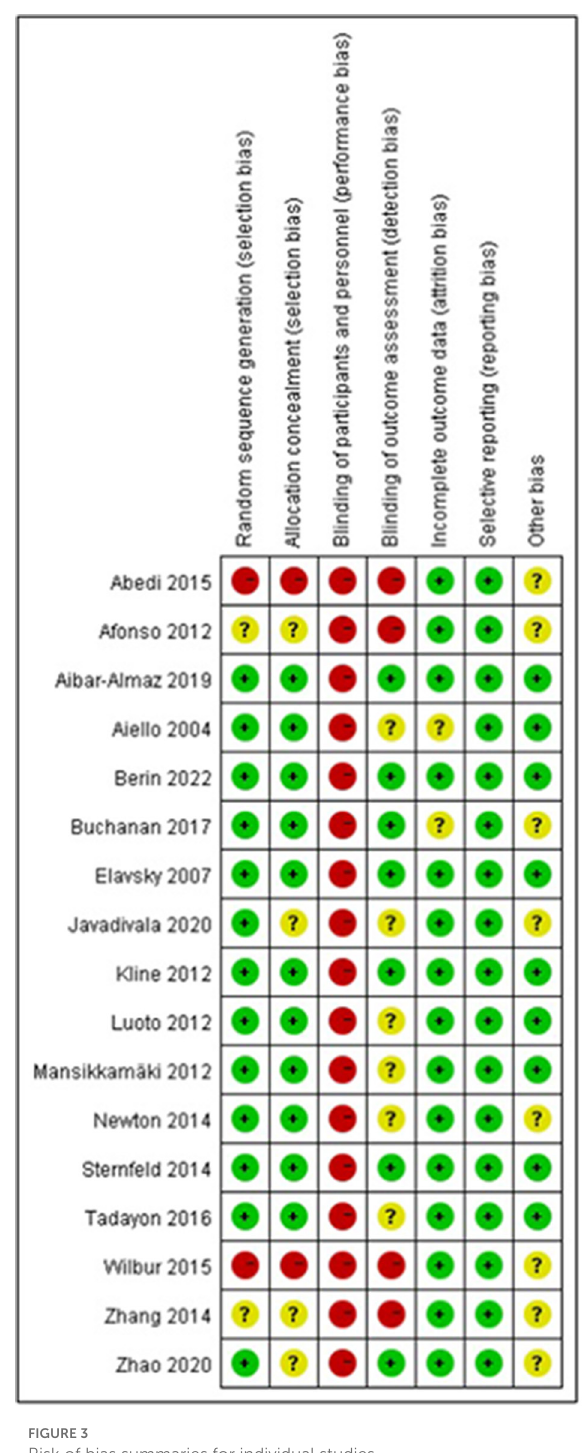
FIGURE3 Risk of bias summaries for individual